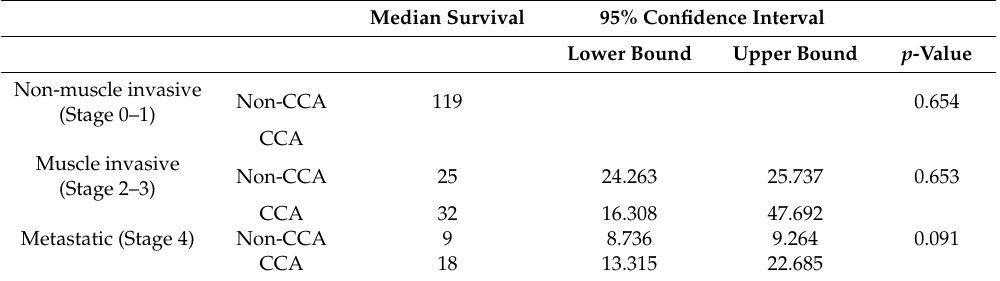
Table 2. Survival comparison between clear cell adenocarcinoma and other urinary bladder cancers stratified by stage.